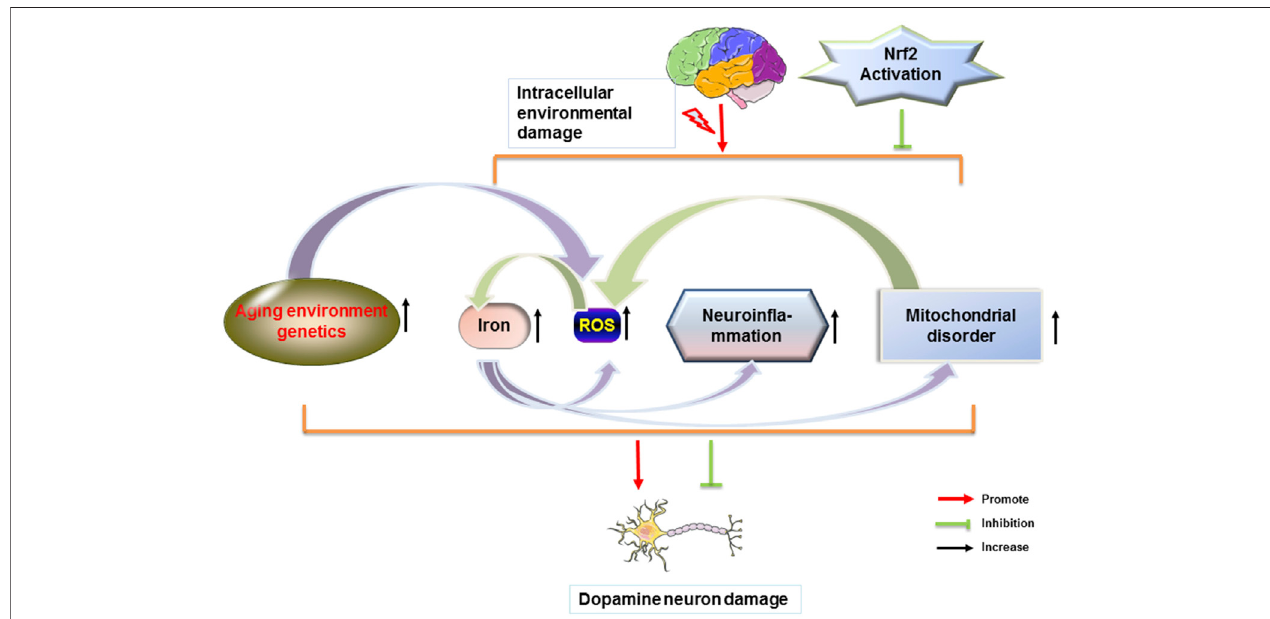
FIGURE 3 | Nrf2 attenuates PD by modulating different factors. Dopamine neurons in the brain are disturbed by different factors. When homeostasis within the brain is dysregulated, a series of changes in the body, such as increased iron content in the brain, ROS production, glial cell-induced immune in fl ammation, and mitochondrial dysfunction occurs. Each factor can cause the loss of dopamine neurons in the brain and the misfolding of proteins to form Lewy body. Nrf2 reduces the loss of dopamine neurons and the formation of Lewy body and further improves